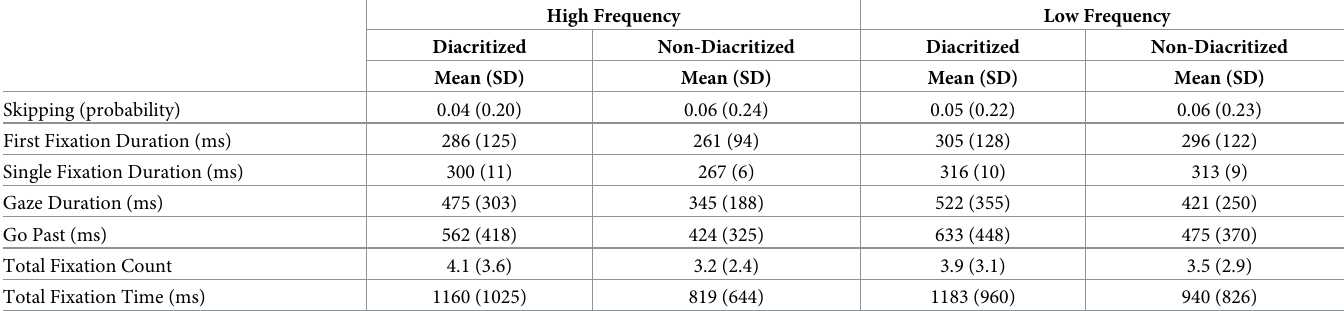
Table 1. Descriptive statistics of eye movement measures at target word region (experiment 1 –word frequency ×